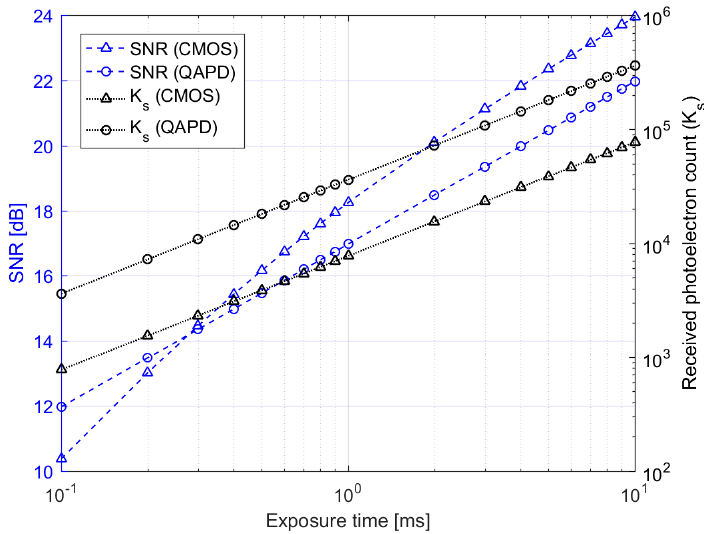
Figure 2. Received photoelectron counts and SNRs versus the exposure time under atmospheric turbulence with A 0 = 1.7 × 10 − 14 m − 2/3 and v = 21 m/s. Given the optical configuration, the centroid error is influenced by not only